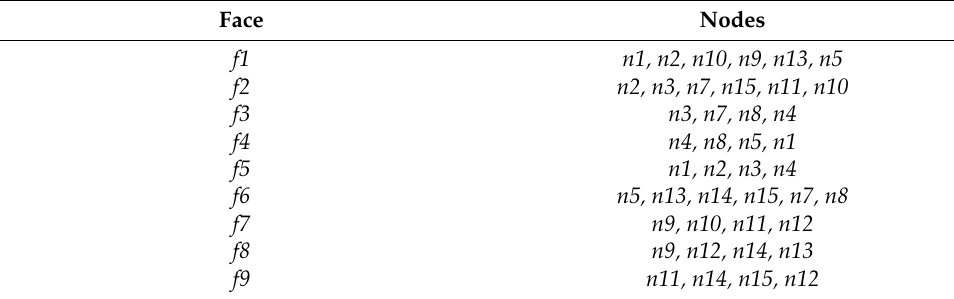
Figure 4. Unit cube after an octant has been removed in a design step. Table 6 shows the face–node–table of the modified unit cube. Table 6. Face–node–table for the modified unit cube.